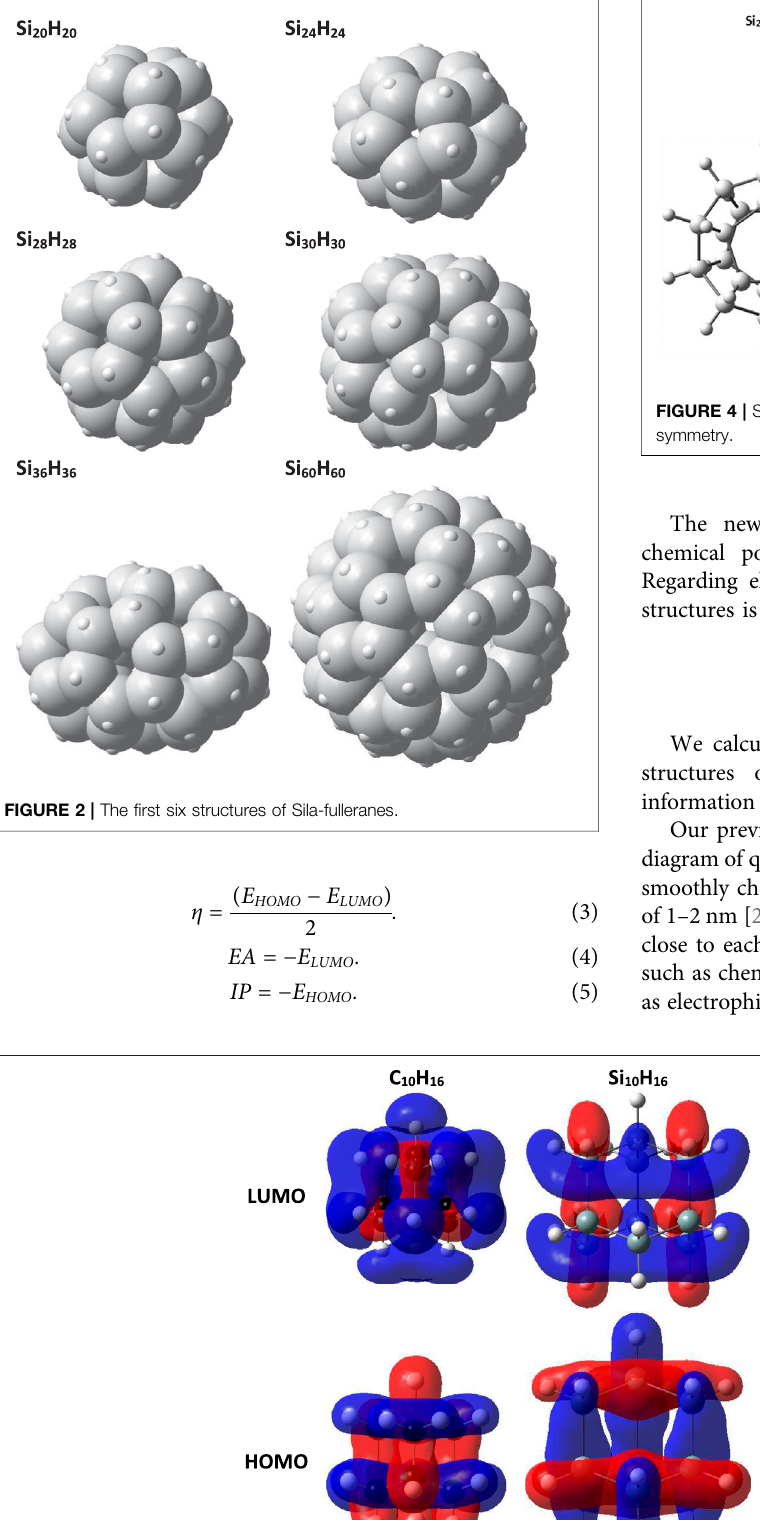
Frontiers in Physics |